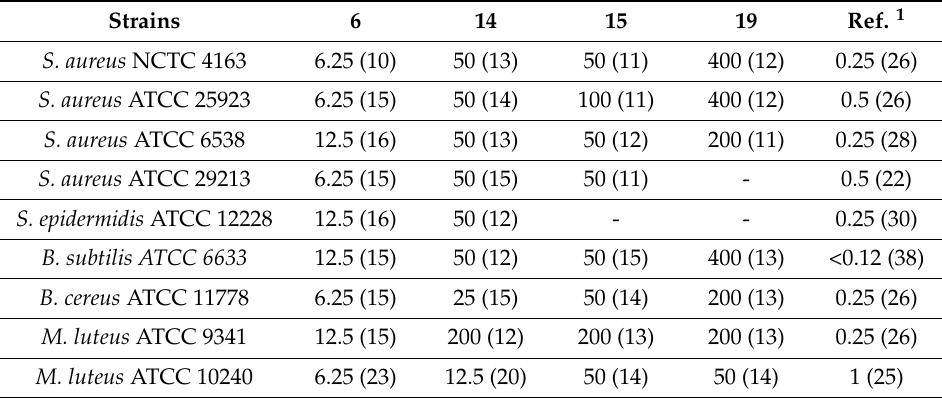
Table 2. Activities against Gram-positive bacteria—minimal inhibitory concentrations (MIC, µ g/mL) and diameter of growth inhibitory zone (GIZ, mm, applied 400 µ g per disc)